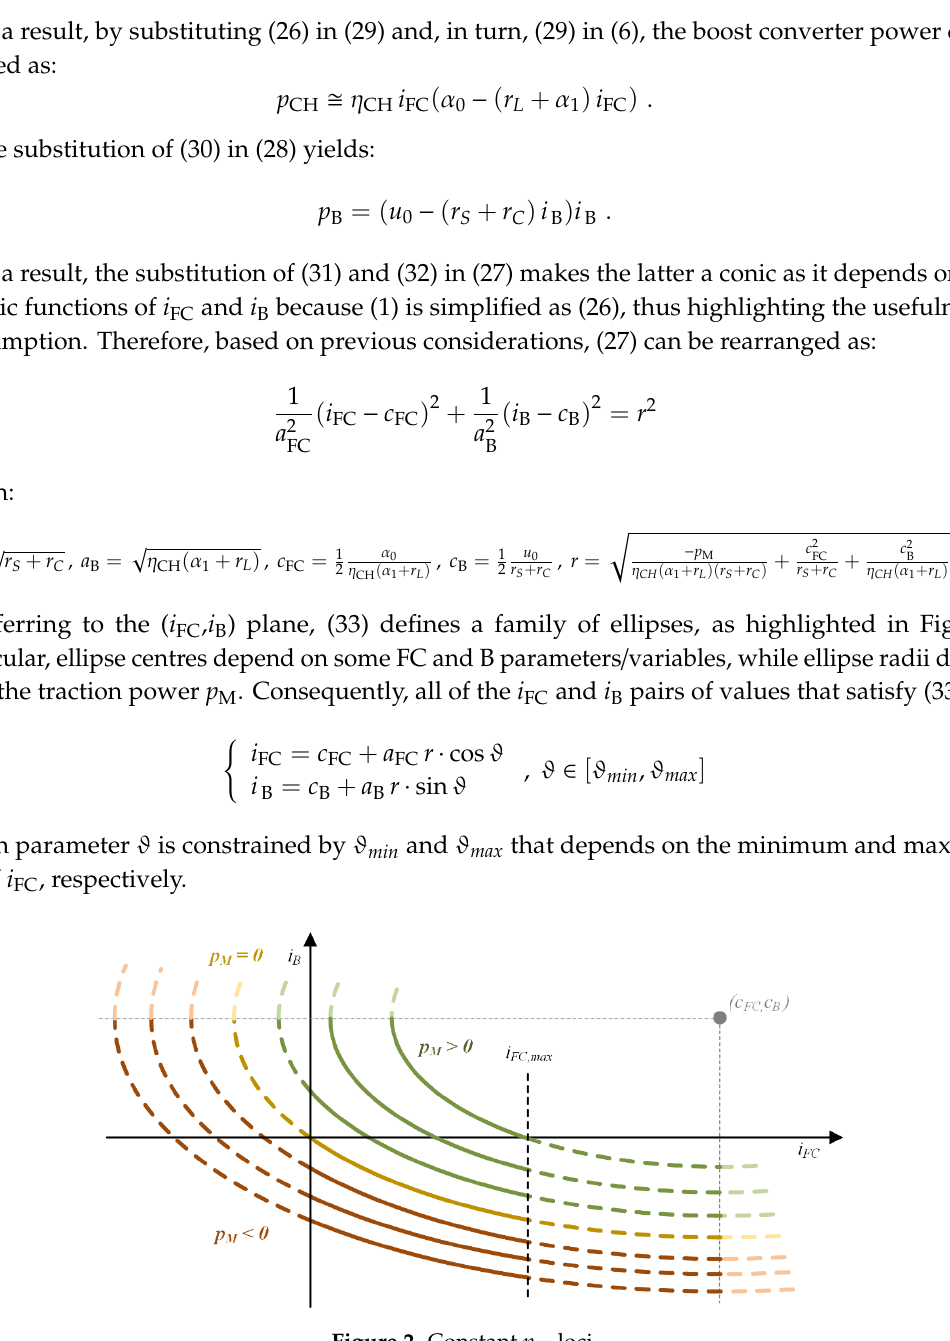
Figure 2. Constant p M loci.